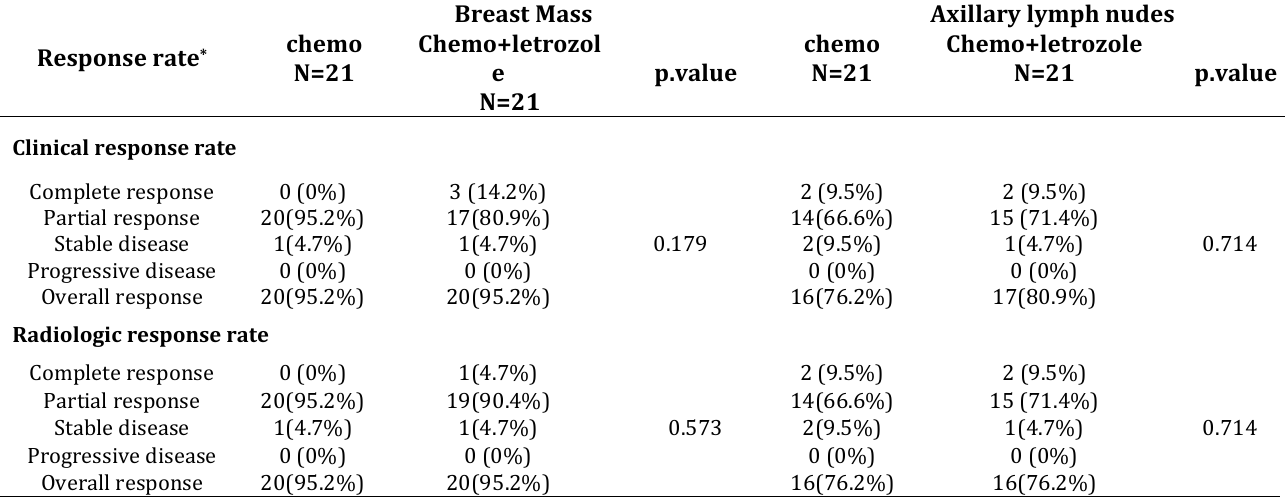
Table 2. Comparison of overall clinical and radiologic response rates after completion of neoadjuvant therapy in both